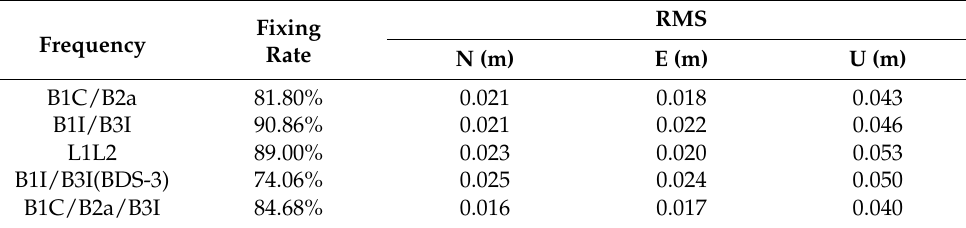
Table 8. TGD2-TGCU (128 km) average of long baseline RTK RMS and ambiguity fixing